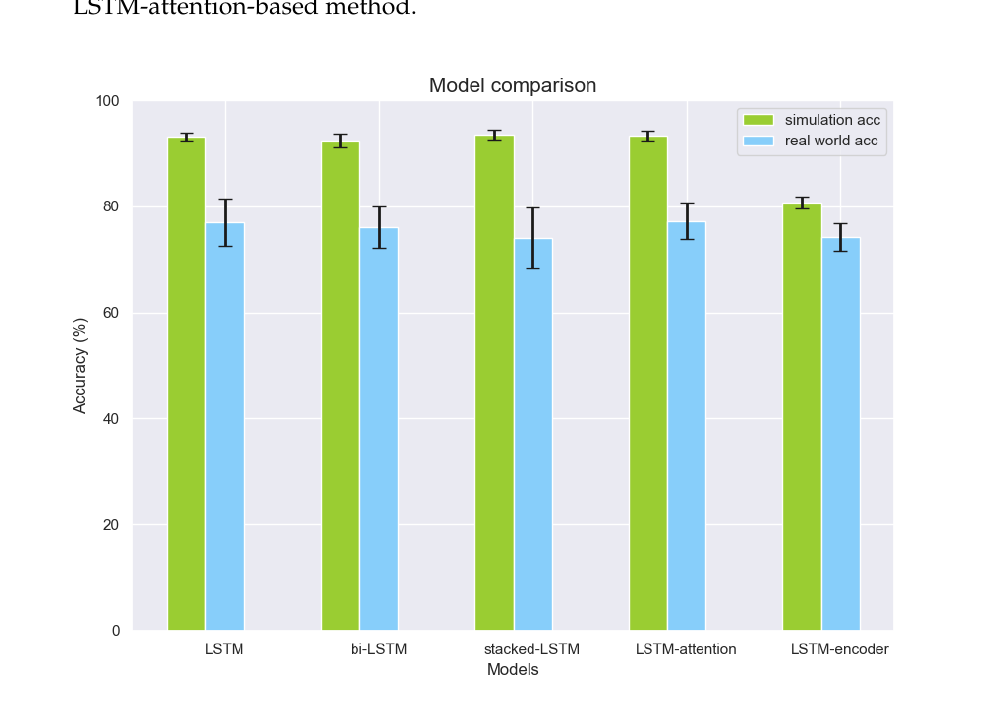
Figure 11. Four-class anomaly detection results from different deep learning architectures. Table 5. The complexity comparison of different